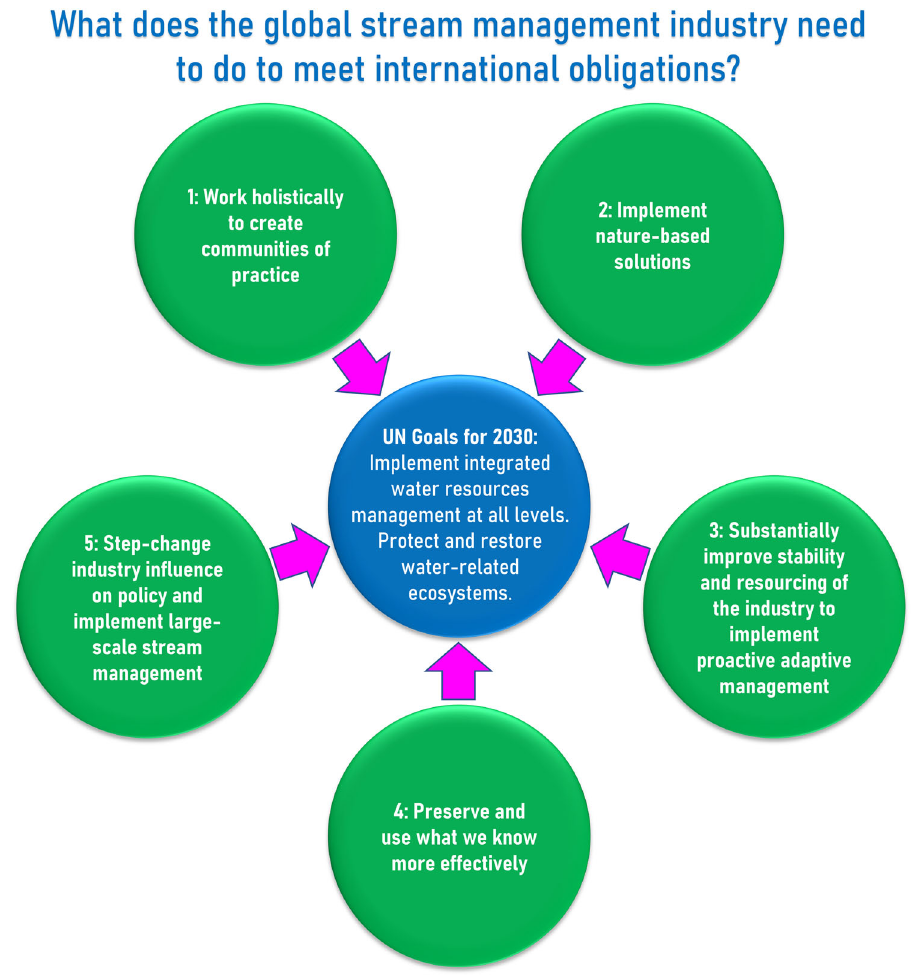
Fig. 7 Five recommendations to support progress towards United Nations (UN) Sustainable Development Goals (SDGs) over the Decade for Ecosystem Restoration to 2030. The fi ve recommendations (in outer green circles) support broader UN goals (in central blue circle), including SDG Target 6.5, ‘ implement integrated water resources management at all levels ’ , and SDG Target 6.6, ‘ protect and restore water-related ecosystems ’